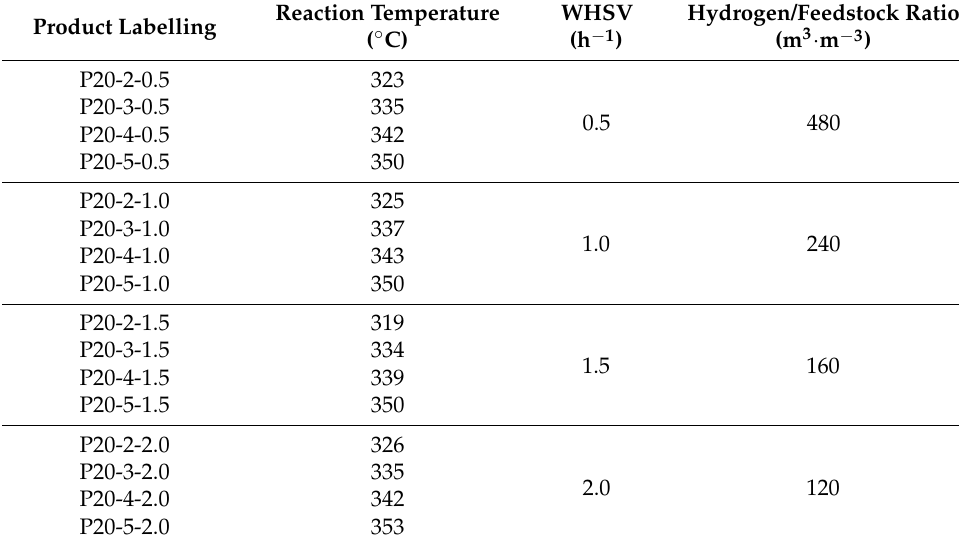
Table 14. The reaction conditions and labelling of the products obtained by hydrotreating the F20 feedstock. Product